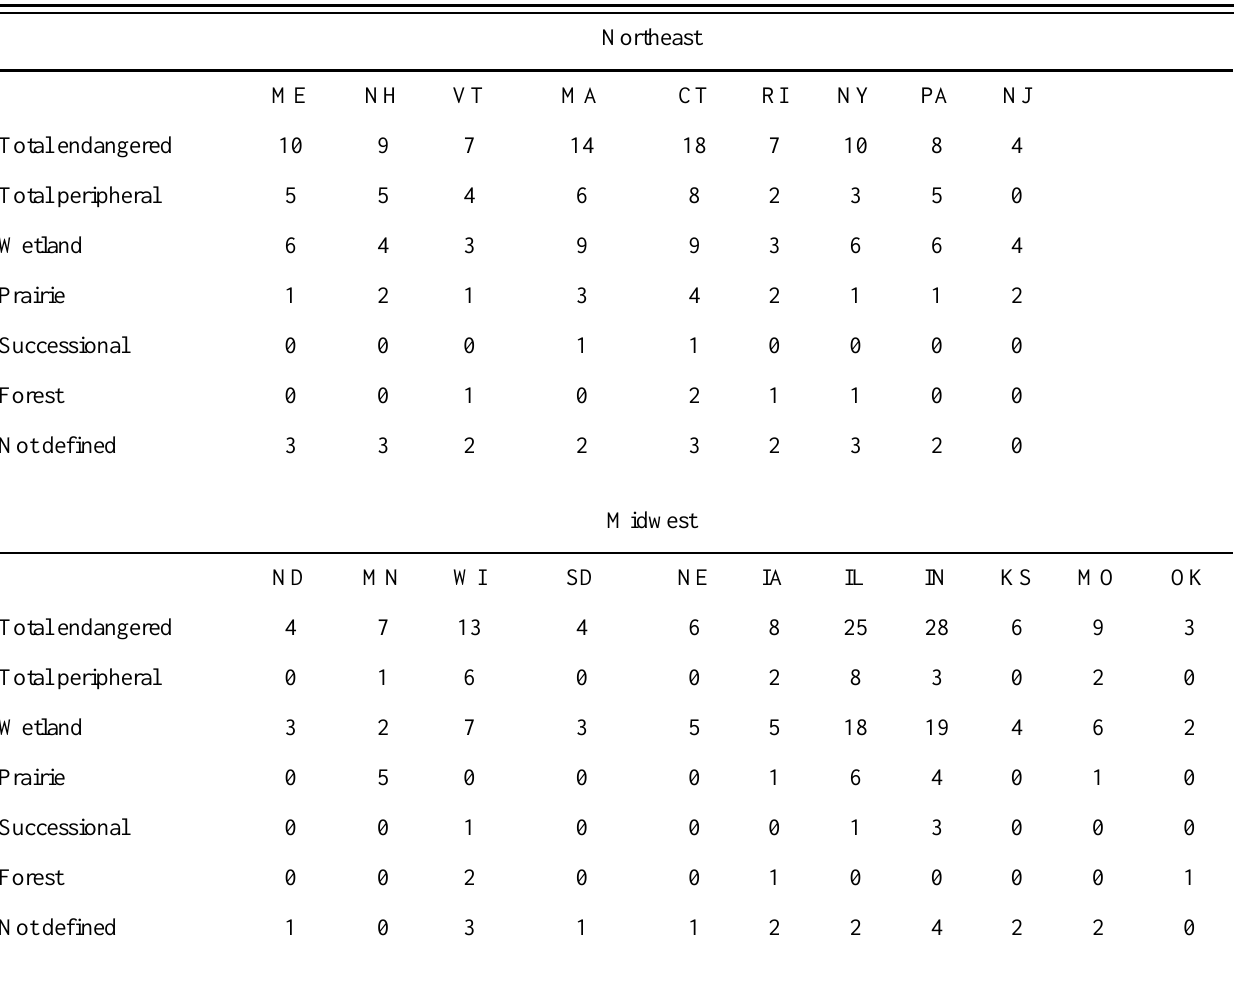
Table 1 . Endangered species totals for the northeastern and midwestern United States.